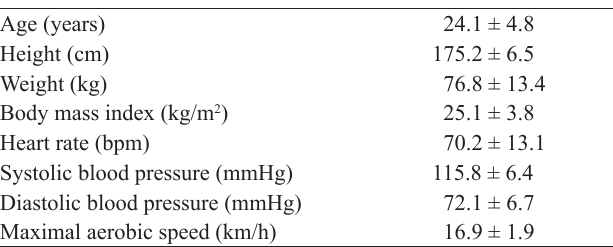
Table 1. Sample characteristics (n = 14)